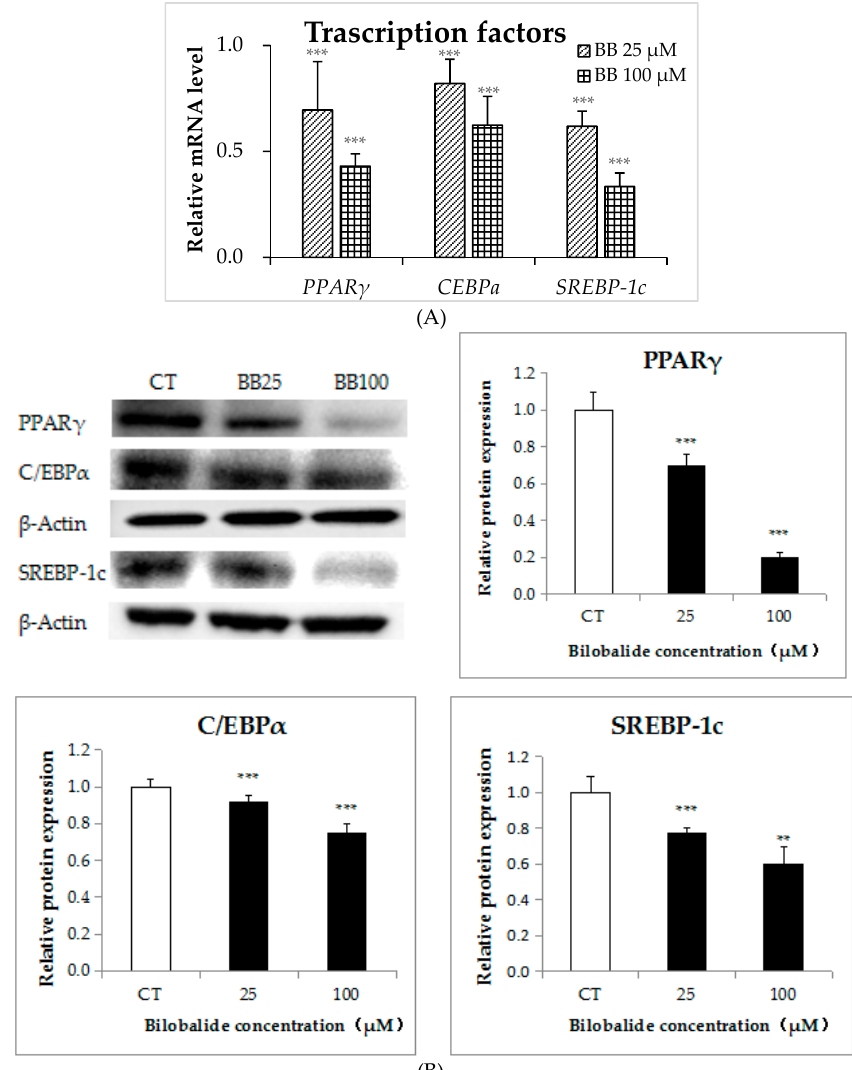
Figure 4. The effects of different bilobalide concentrations on adipogenic transcription factors. (A) The mRNA expression of PPAR γ , CEBP- α , and SREBP-1c . (B) Western blot analysis of PPAR γ , CEBP- α , and SREBP-1c protein levels. Histograms show quantification of protein levels according to band intensities. Data are presented as the mean ± standard deviation (( n = 3). * p < 0.05, ** p < 0.01, *** p < 0.001.